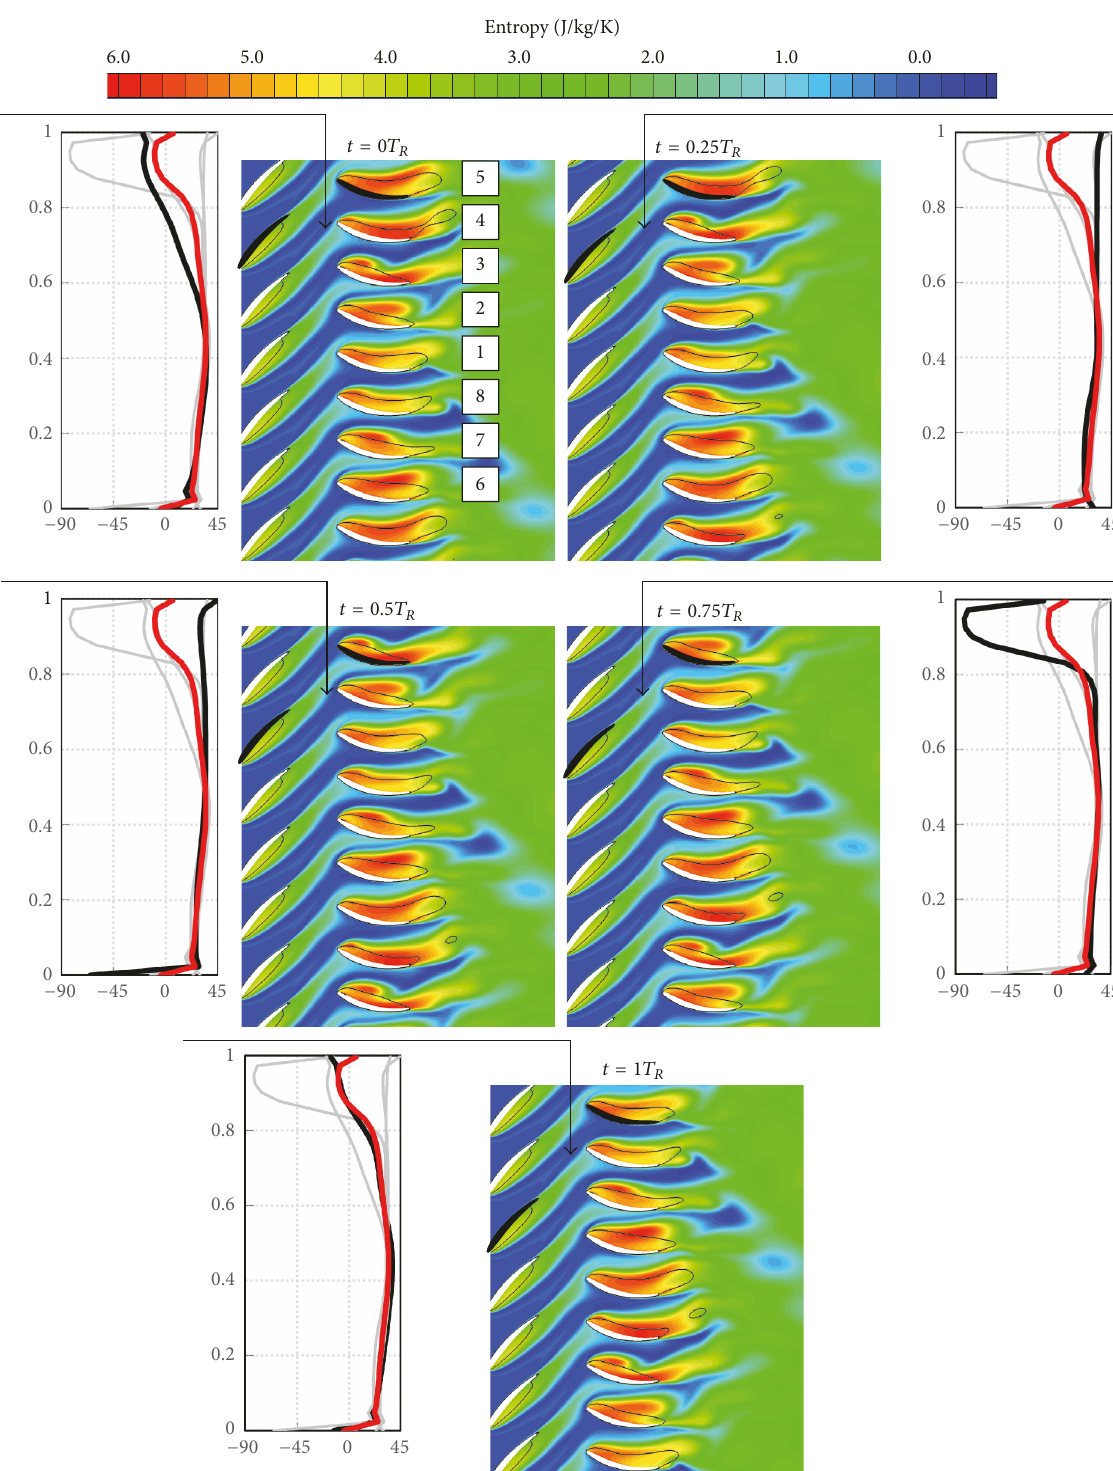
Figure 13: Numerical entropy contours and zero axial velocity isoline on a blade-to-blade view at stator midspan. Absolute angle radial distributions at a given time step (black line) with mean profile in